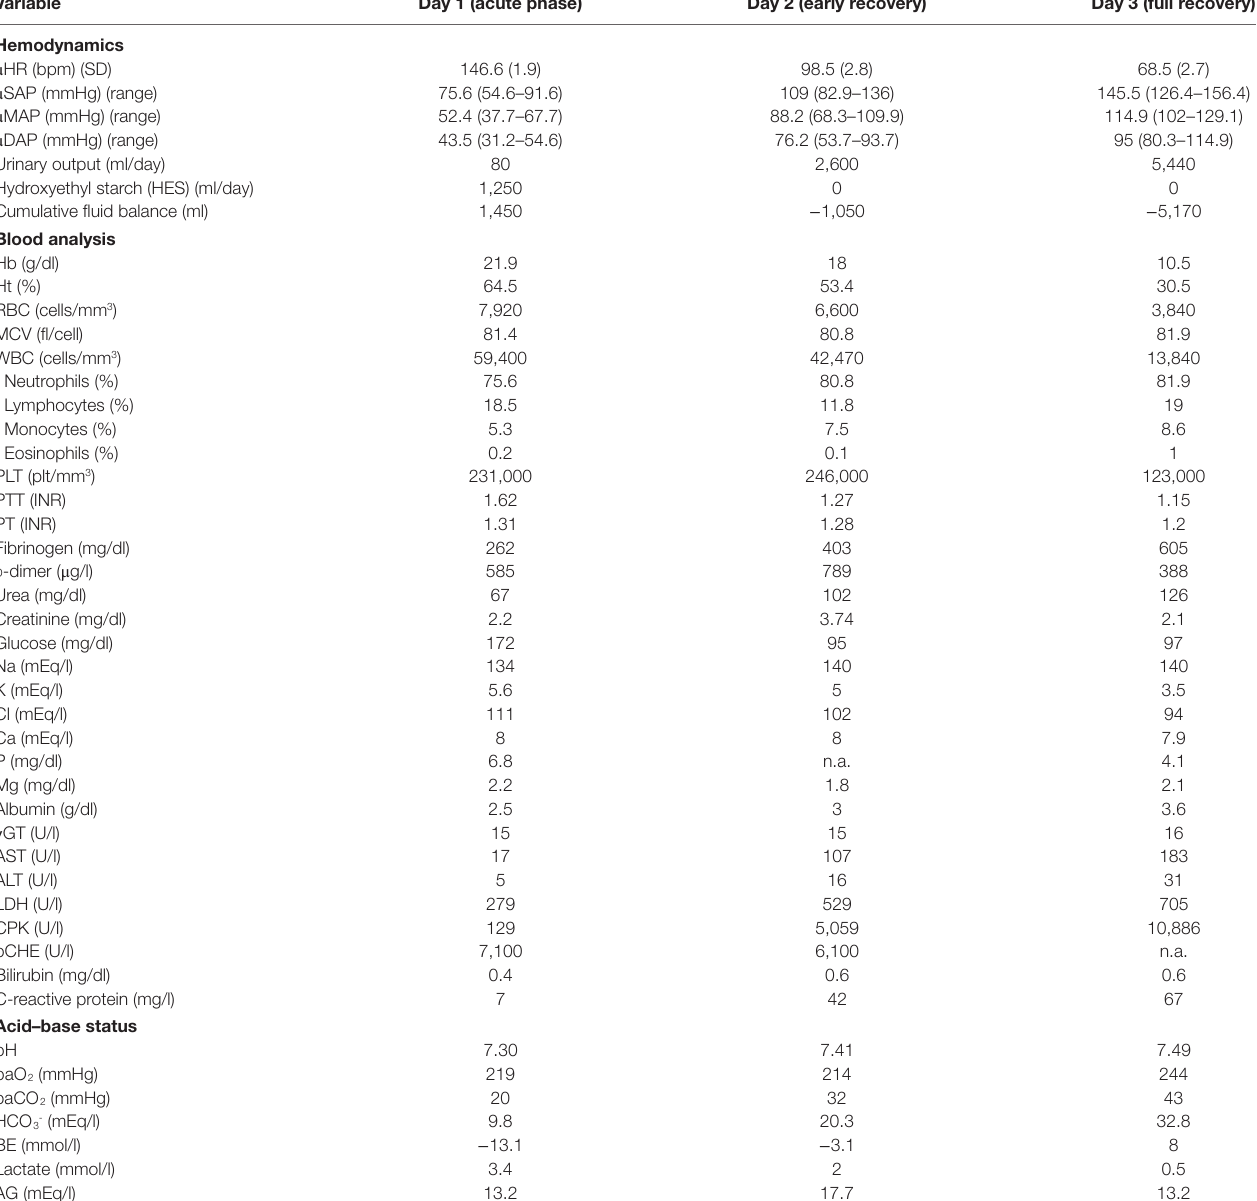
tabLe 1 | Hemodynamic data, blood sample analyses, and acid–base status during the ICU stay.